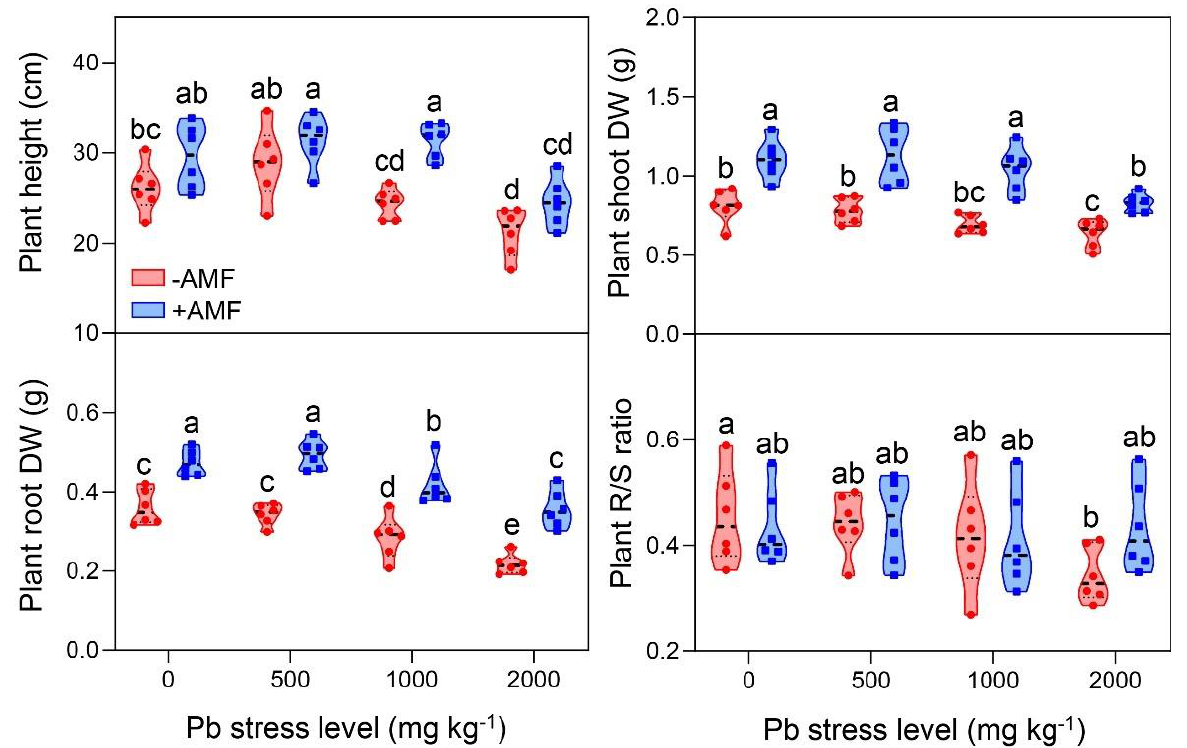
Figure 1. Plant height, shoot dry weight, root dry weight, and root/shoot (R/S) ratio of B. parviflora under different treatments. Dry weight (DW); Pb stress level (0, 500, 1000, and 2000 mg kg − 1 ); non-mycorrhizal inoculation ( − AMF); F. mosseae inoculation (+AMF). Data represent mean ± SD for biological replicates ( n = 6). The same letter indicates no significant difference (Duncan’s test, p < 0.05).